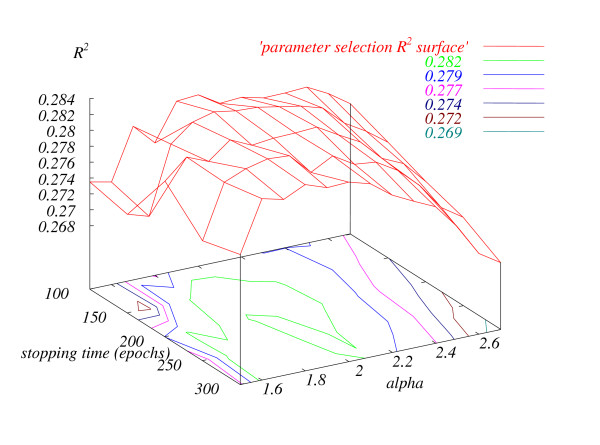
The dependence of R2 on the two neural network training parameters, ALPHA and stopping time. The lower part of the figure shows the contours of the surface. For instance, the inner-most light green shape delineates the parameter values giving R2 ≥ 0.282.